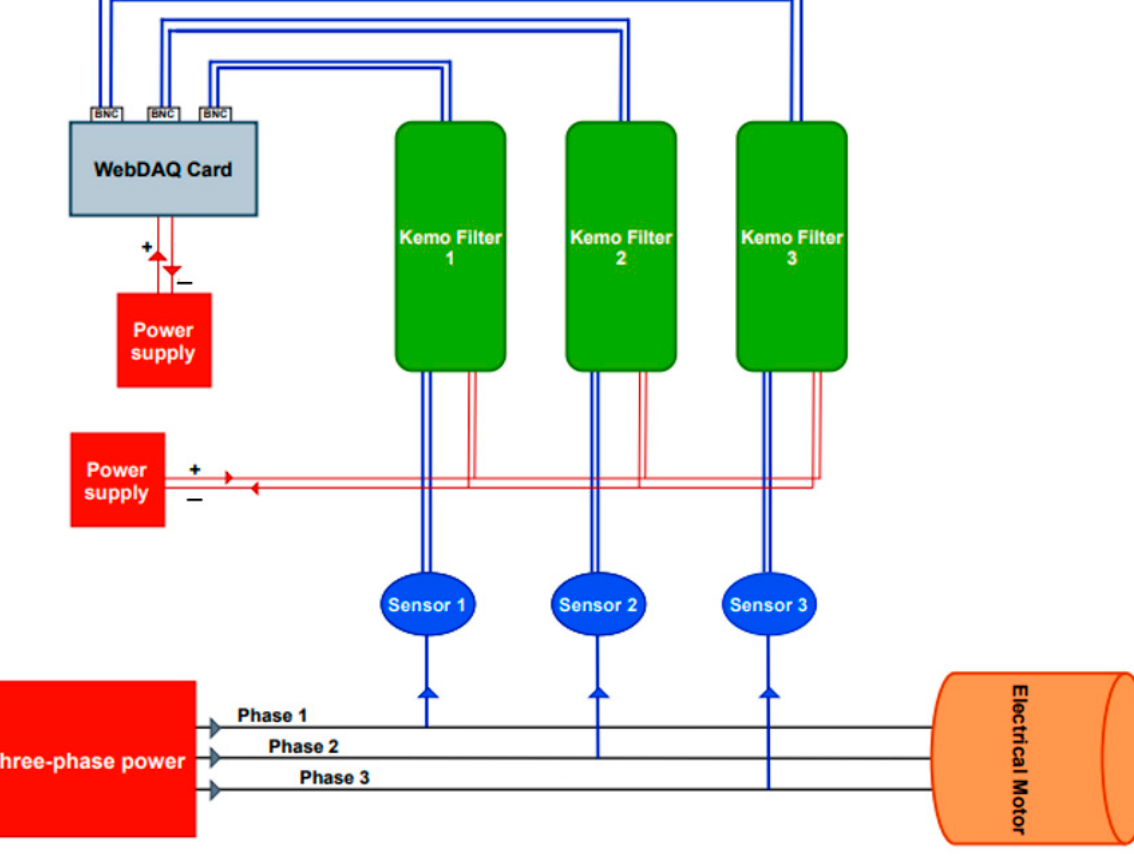
Figure 4. Schematic of the data acquisition system. The continuous-captured current signals were passed through KEMO amplifiers/anti- aliasing filters, which are used to amplify and limit the frequency bandwidth of the recorded signals to satisfy the Nyquist-Shannon sampling theorem. Filters with a gain of × 20 and a cut-off frequency of 8 kHz were adopted in the experiments. For the conversion of the analog signals (the KEMO filters output) into digital signals, a WebDAQ 504 data acquisition card was used, with simultaneously sampled analog inputs, 24-bit resolution, and IEPE signal